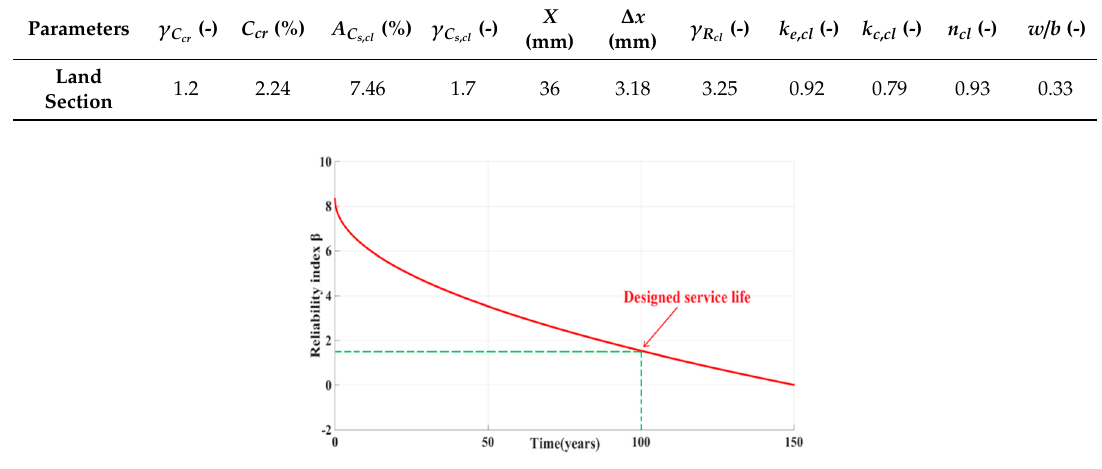
Figure 18. Reliability index calculated by the Monte-Carlo simulation (land section).